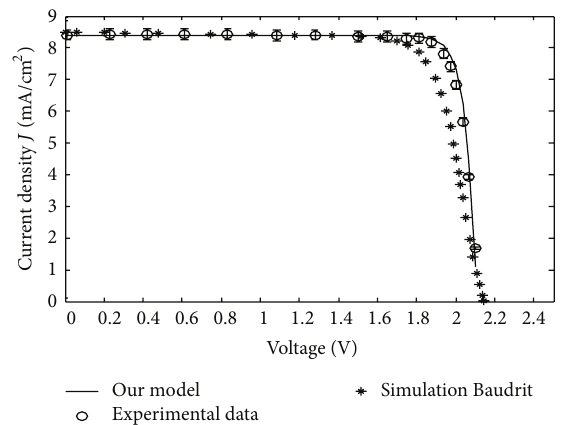
Figure 2: The experimental and simulation data for dual junction current density versus voltage. Circles correspond to experimental data, stars to results of Baudrit and Algora [7] and line to our